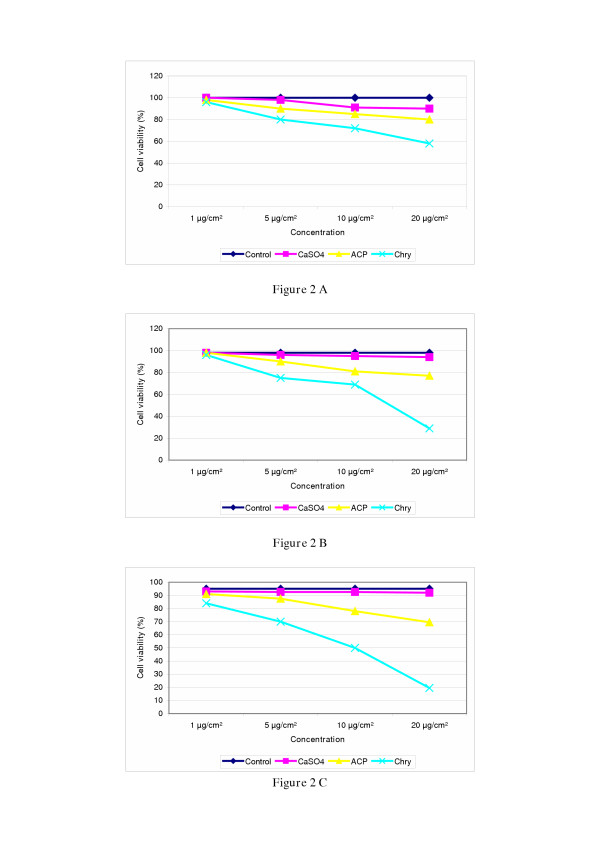
Cytotoxicity of asbestos-cement in V79-cells. Cells were treated with various doses (1 μg/cm2, 5 μg/cm2, 10 μg/cm2, 20 μg/cm2) of asbestos-cement and chrysotile for 24 hrs (A), 48 hrs (B) and 72 hrs (C). The percentage of decreased cell viability is shown in relation to the untreated control. The cytotoxicity was determined by trypan blue-staining. The experiments were repeated twice. SD < 1%